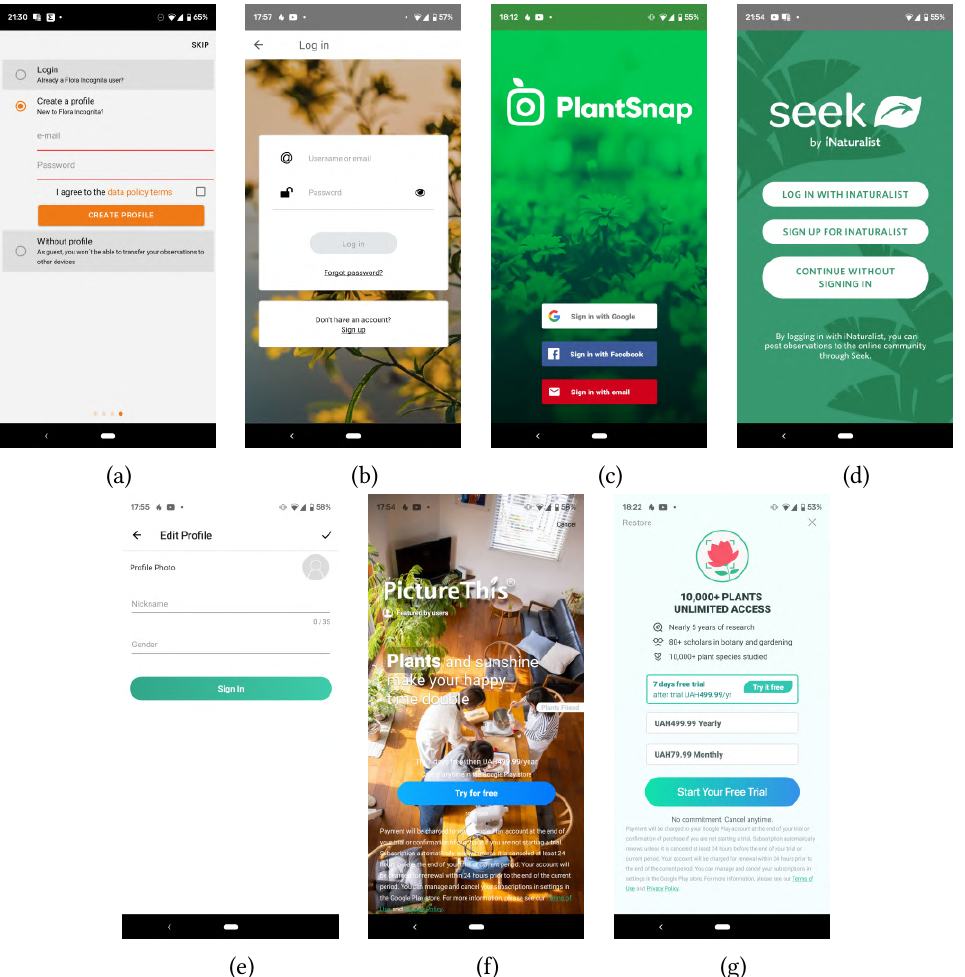
Figure 1: Login process of Flora Incognita (a), PlantNet (b), PlantSnap (c), Seek (d), Picture-This (e), and PictureThis’s aggressive advertise (f,